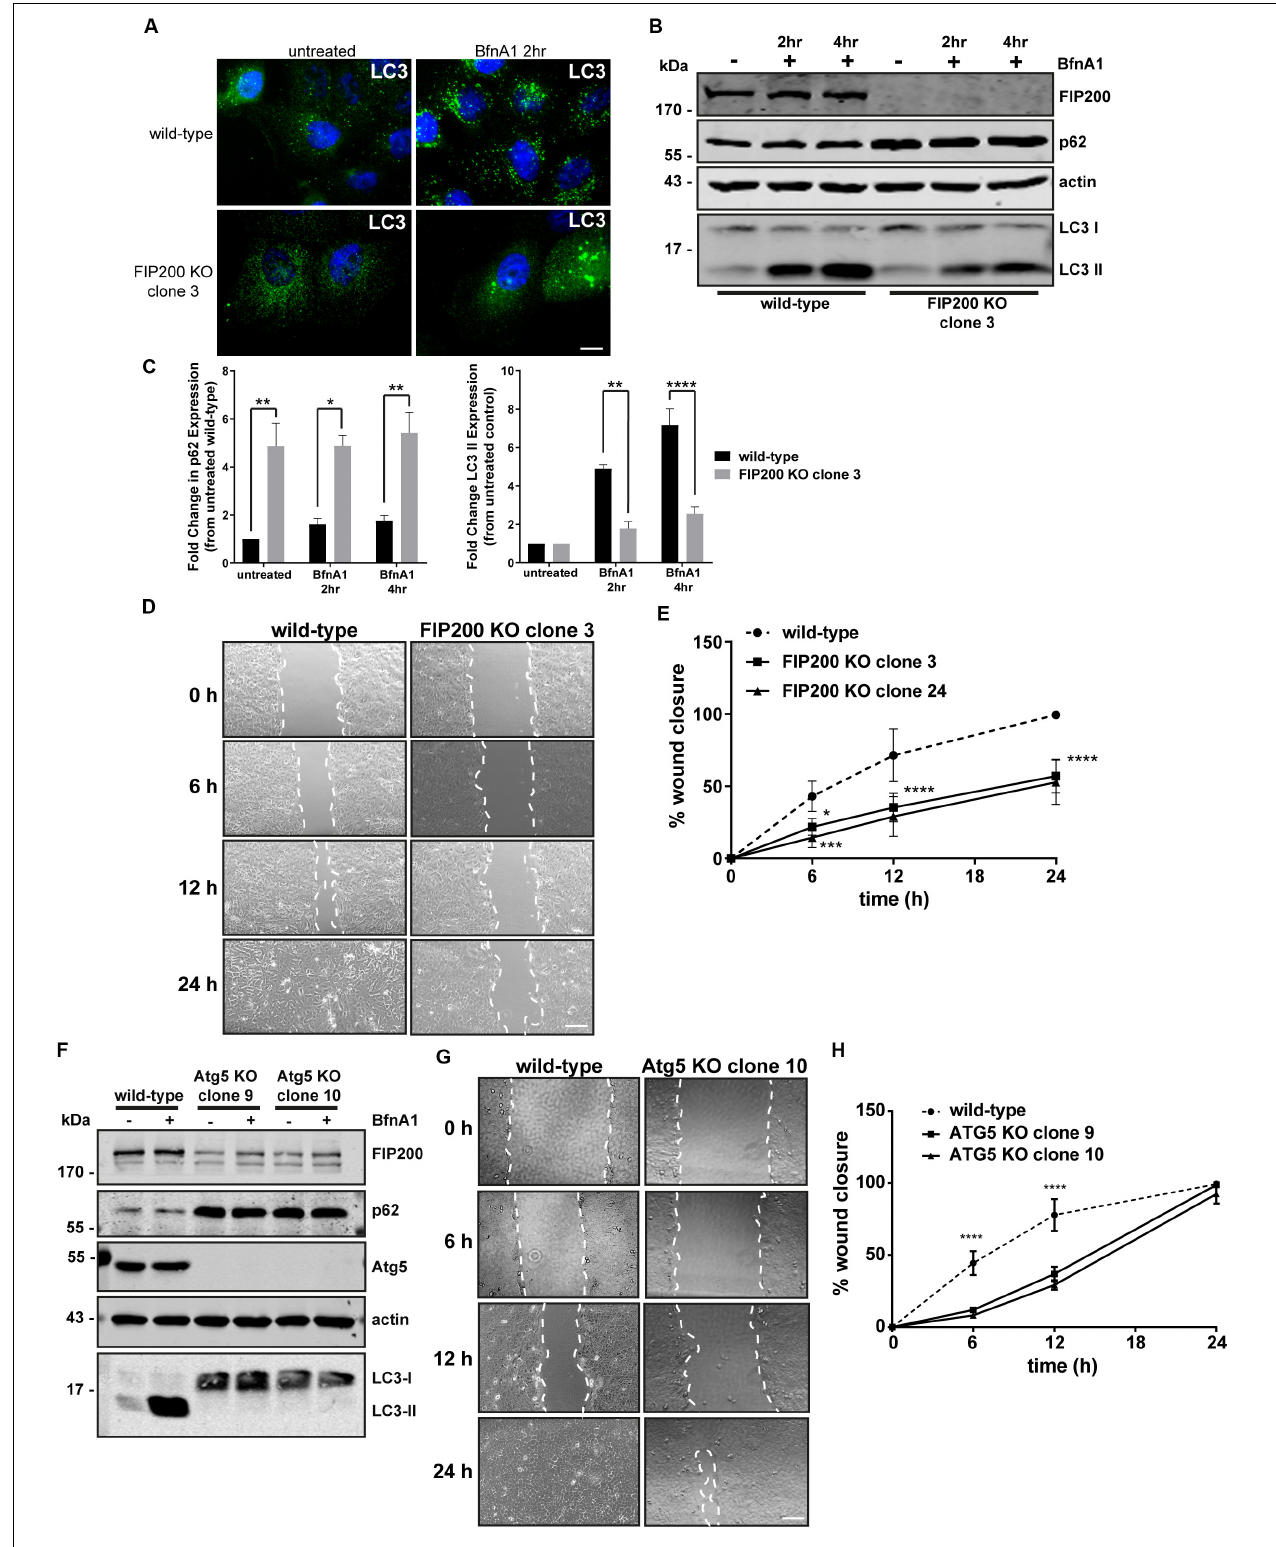
FIGURE 1 | Loss of the autophagy regulators FIP200 or Atg5 results in inhibition of directional cell motility. (A) Wild-type and FIP200 knockout (KO) MCF10A cells processed for immunofluorescence microscopy and immunostained for LC3 (green). Nuclei are labeled with Hoechst (blue). Scale bar = 10 µ m. (B) Western blot